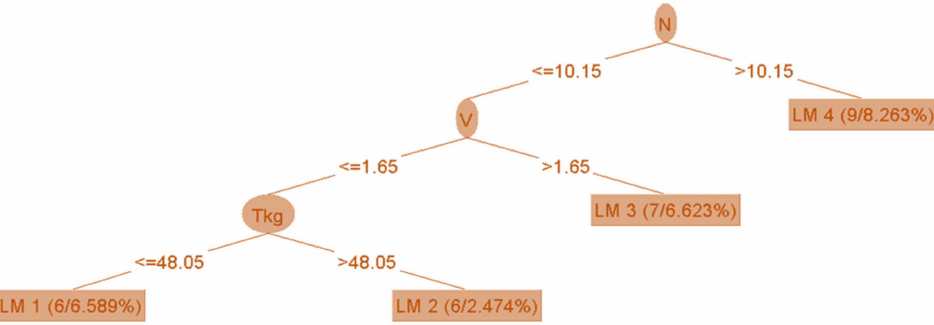
Figure 4. The decision tree algorithm structure for the estimation of MR